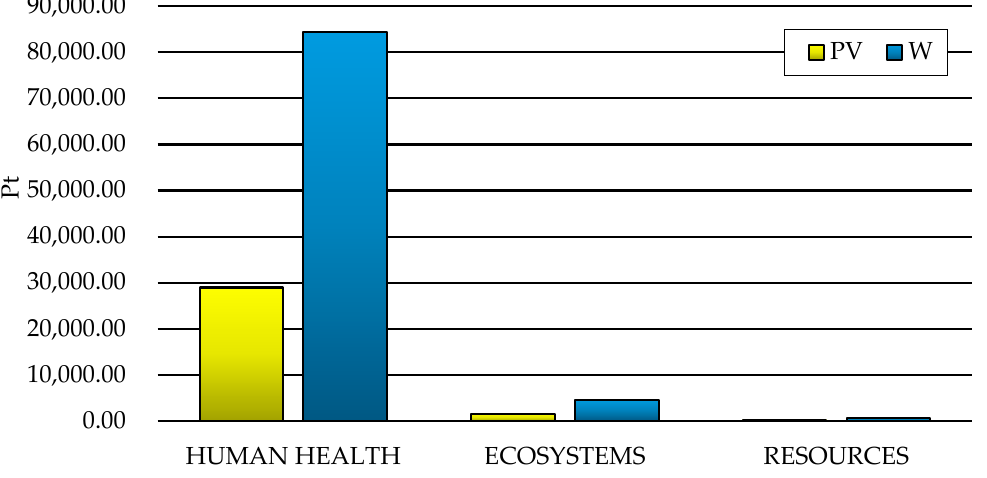
Figure 7. Grouping and weighting results of environmental effects for areas of influence present in the life cycle of wind (W) and photovoltaic (PV) power plants (unit: % and Pt)—triangle view.